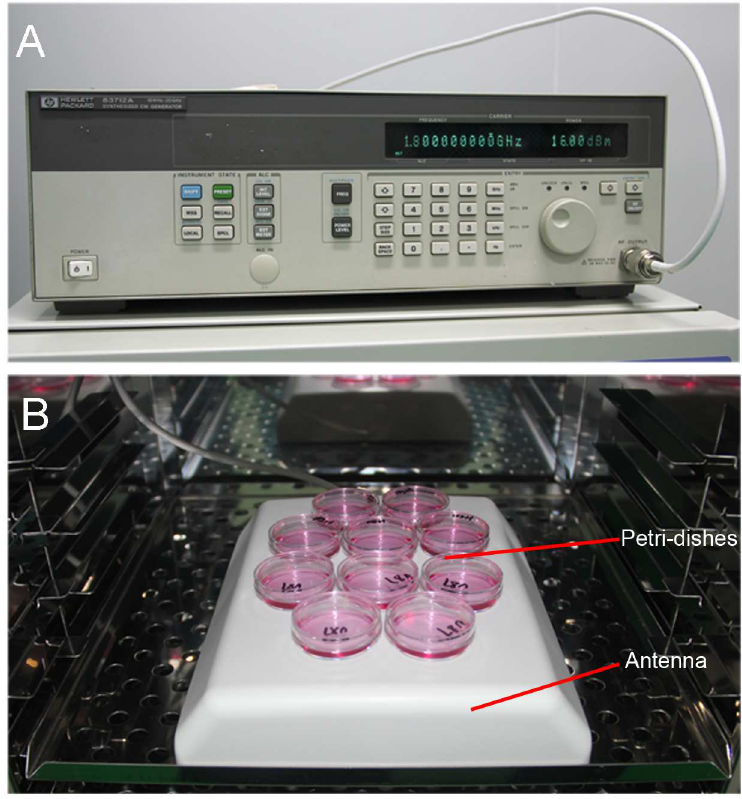
Fig 1. The microwave exposure system. (A) 1800MHzmicrowave generator. (B) Antenna in an incubator. The antenna was connected to a microwave generatorvia a flexible coaxial cable and enclosedin a humidifiedincubator. Petri dishes were positionedon the top of the antenna and cells in petri dishes were exposed to continuousmicrowave radiation at 1800MHz 1209 mW/m 2